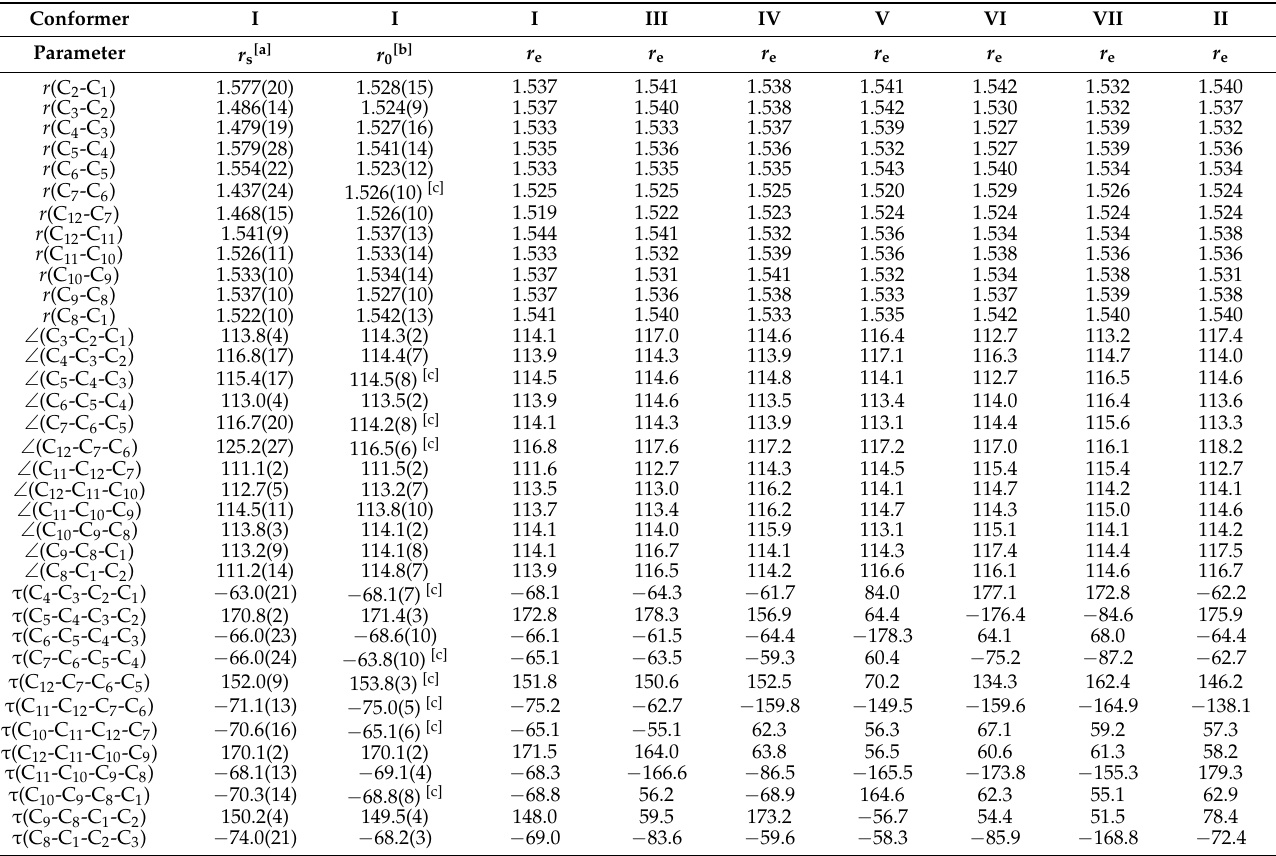
Figure 2. r s structure of conformer I (blue spheres indicating the position of the C atoms) overlapped with B3LYP-D3BJ/6-311++G(d,p) (grey framework), including atom labelling. Table 3. Substitution and effective experimental bond lengths (Å), angles and dihedral angles ( ◦ ) of conformer I of cyclodode- canone and B3LYP-D3BJ/6-311++G(d,p) equilibrium structural parameters of all observed conformers of